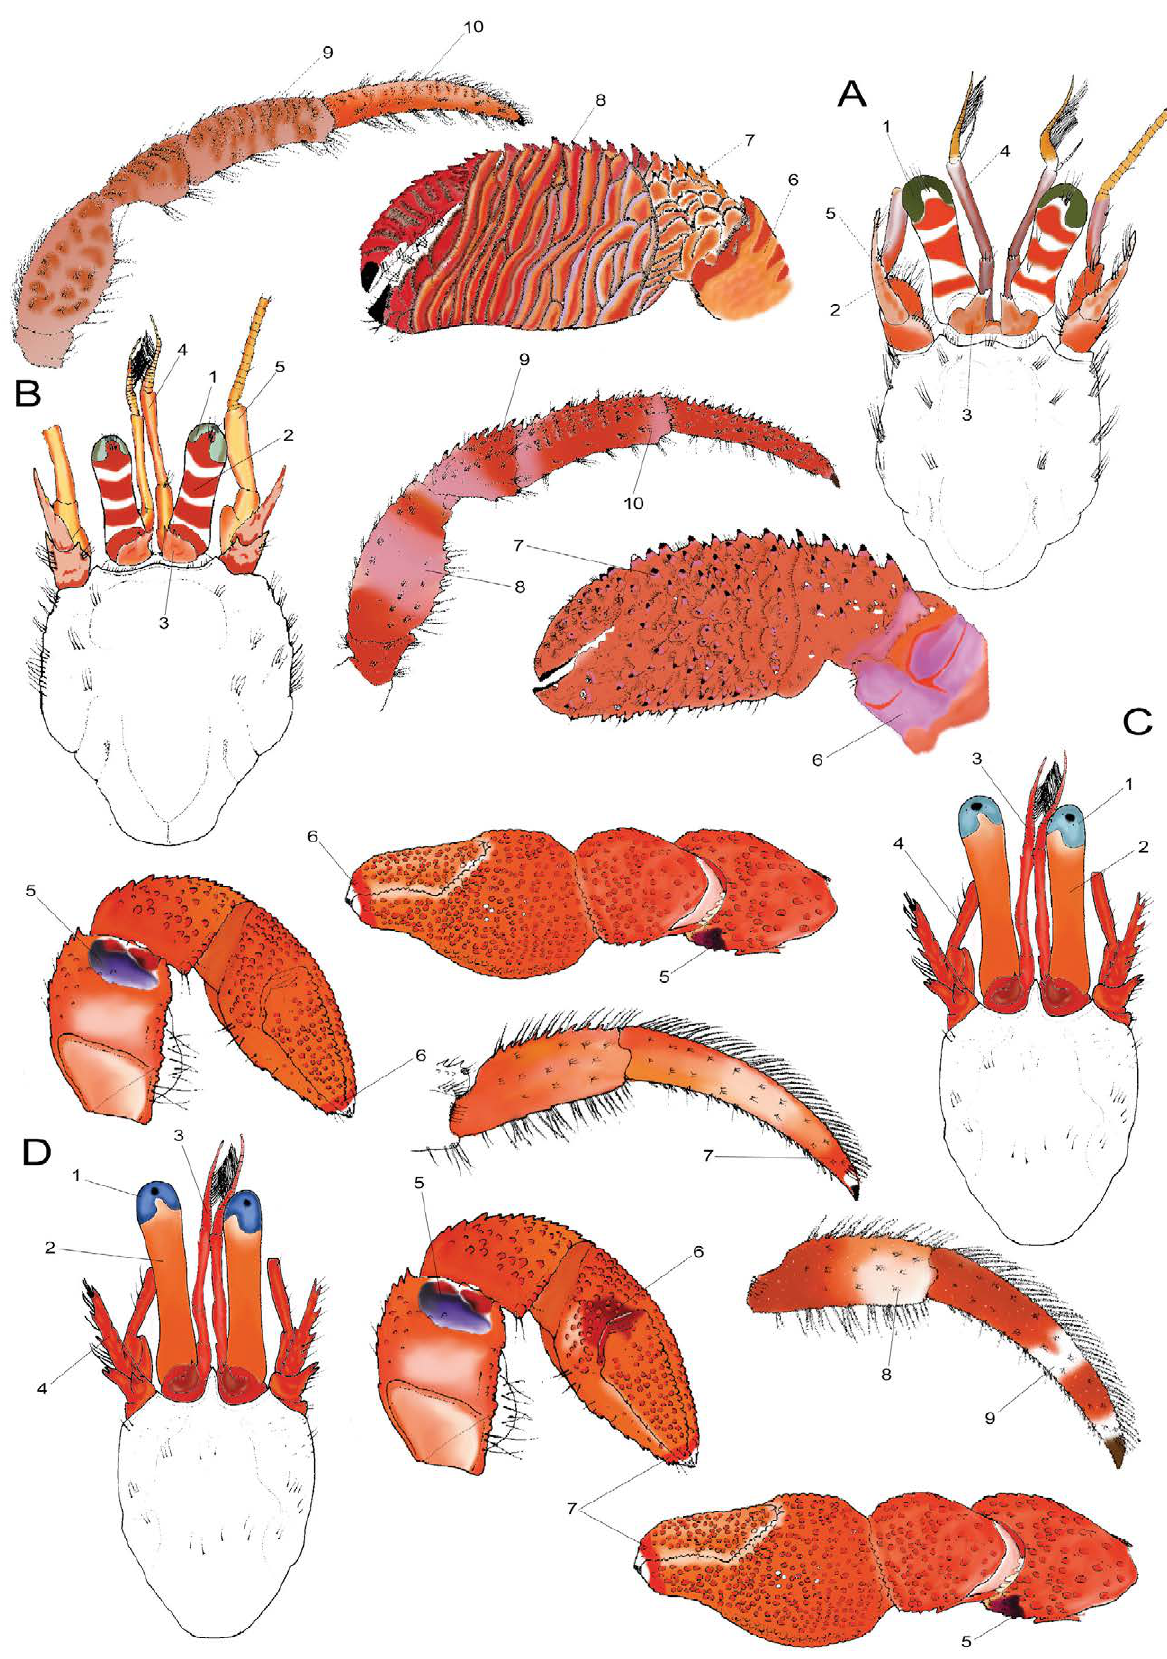
Fig. 3. – Colour patterns of the Diogenidae species: Dardanus arrosor (A, 1-10); Dardanus calidus (B, 1-10); Paguristes eremita (C, 1-7); Paguristes rubropictus (D, 1-9). All vectorial drawings modified from Ingle